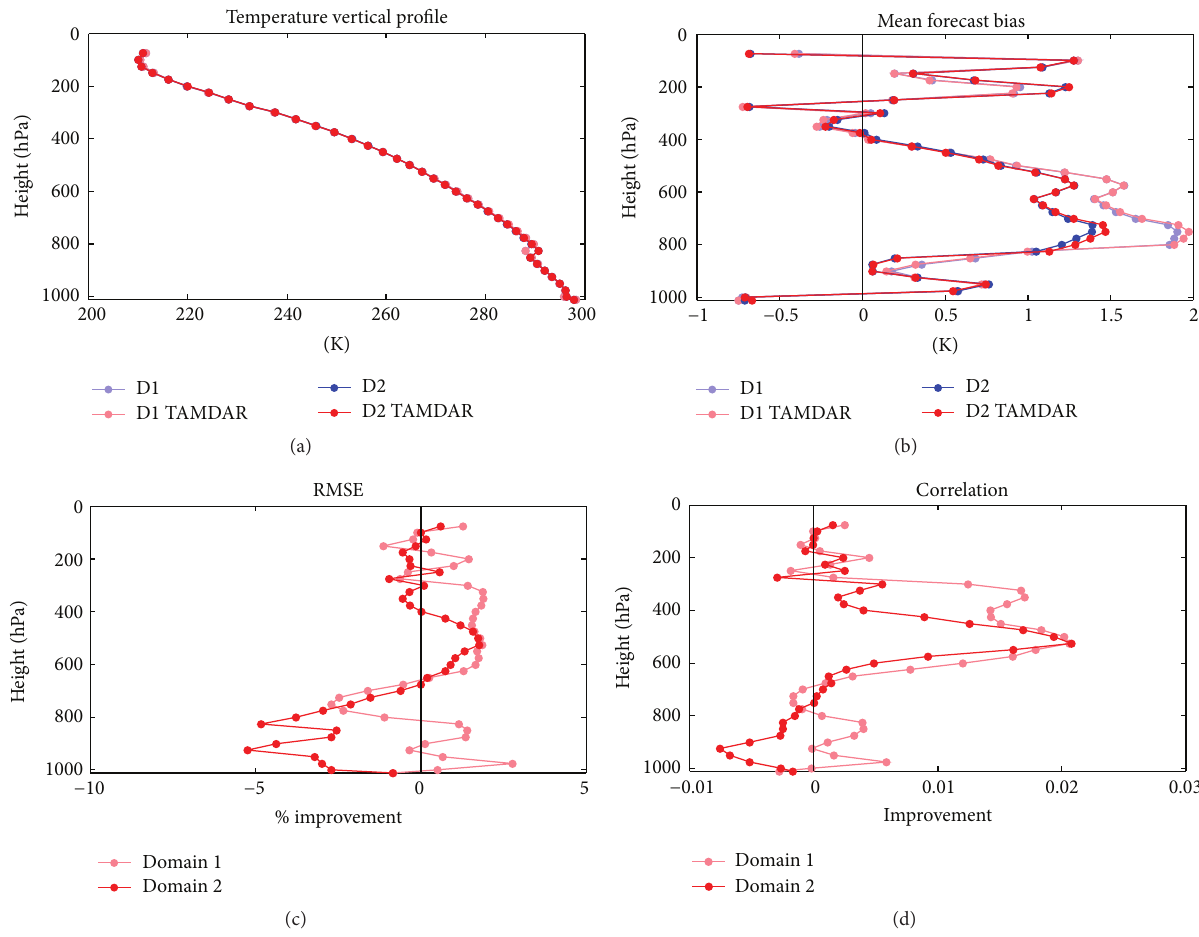
Figure 5: Vertical profiles of temperature (a) mean values (K), (b) mean forecast biases (K), (c) percentage improvement for RMSE, and (d) correlation improvement averaged over all locations and simulation period. Red and blue lines in (a) and (b) show model runs without the TAMDAR data and with the TAMDAR data, respectively (Domain 1: light color; Domain 2: dark color). Percentage improvement for RMSE and correlation improvement due to the assimilation of the TAMDAR data for Domain 1 and Domain 2 are represented in (c) and (d) by light and dark red lines,